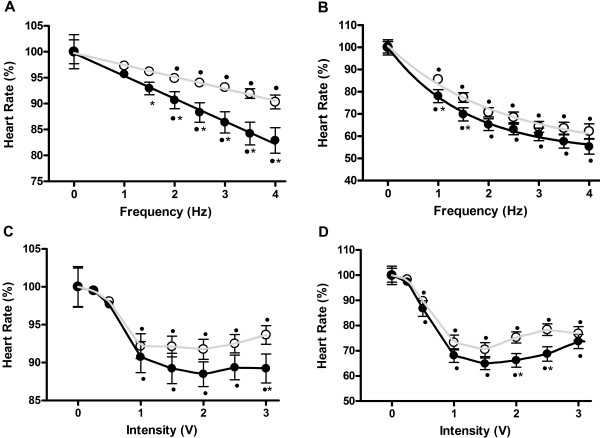
Vagal nerve stimulation in whole-animals. A 2 ms electric stimulation was delivered to the vagal nerve − at increasing frequency but fixed voltage (2 V) or increasing voltage at a fixed frequency (1.5 Hz) − in the absence (A and C) or presence of 0.3 mg/Kg physostigmine (B and D). In absence of physostigmine chagasic rats (open circles) the heart rate decreased proportionally to stimulus frequency (panel A) or intensity (panel C). Physostigmine increased the vagal response in both groups; however, when higher stimulation frequencies were applied(i.e., ≥ 3 Hz), the vagal response of chagasic animals became similar as compared with healthy rats. p < 0.05 indicated statistical significant differences between groups (*) or to the basal rate (·).